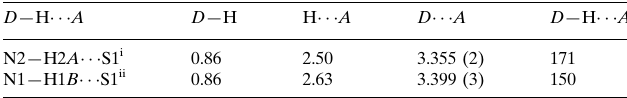
Hydrogen-bond geometry (A˚ , (cid:2)